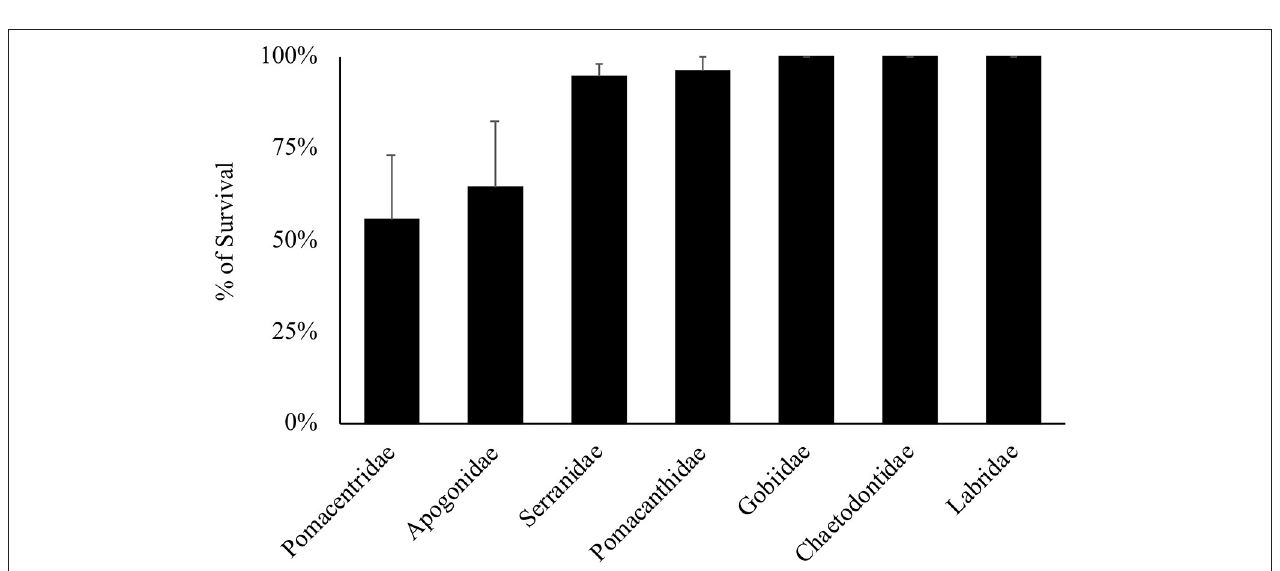
FIGURE 7 | Survival rates of the main families of reef fishes decompressed through the chamber. Only families with sample sizes of more than three specimens are presented.